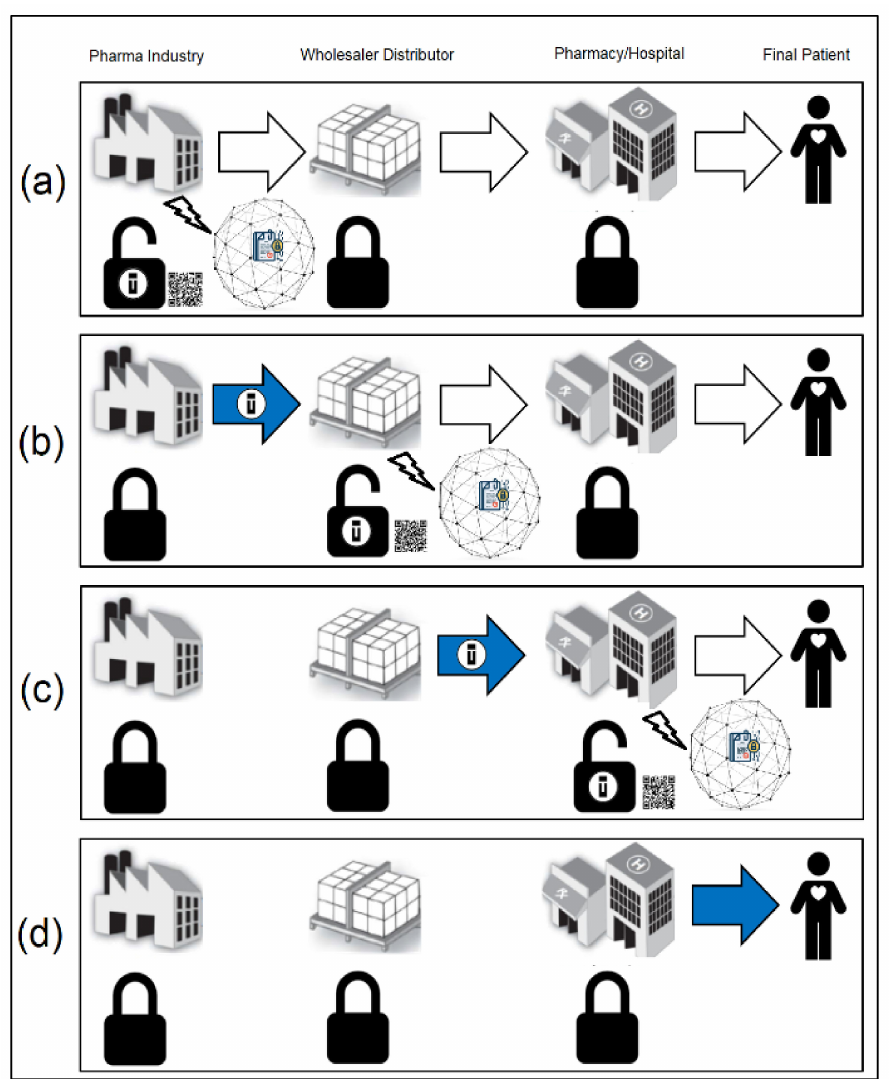
Figure 6. An example of robust track and trace process with NFT serialization: ( a ) the NFT is minted; ( b ) the ownership is passed the warehouse; ( c ) the ownership is passed to the hospital retailer; ( d ) the NFT is burnt as soon is administered to the